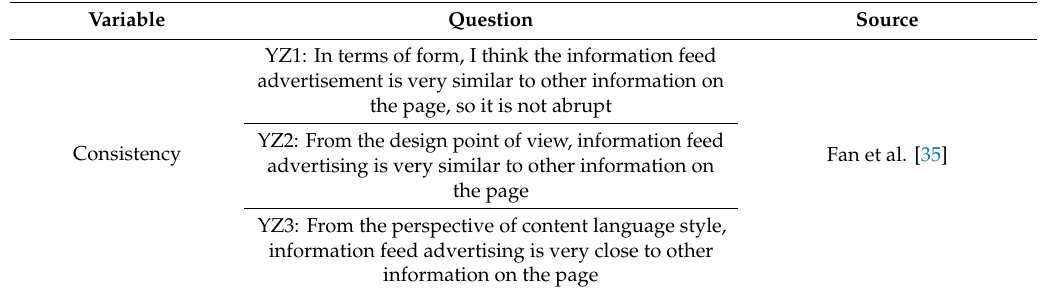
Table 1. Variables and